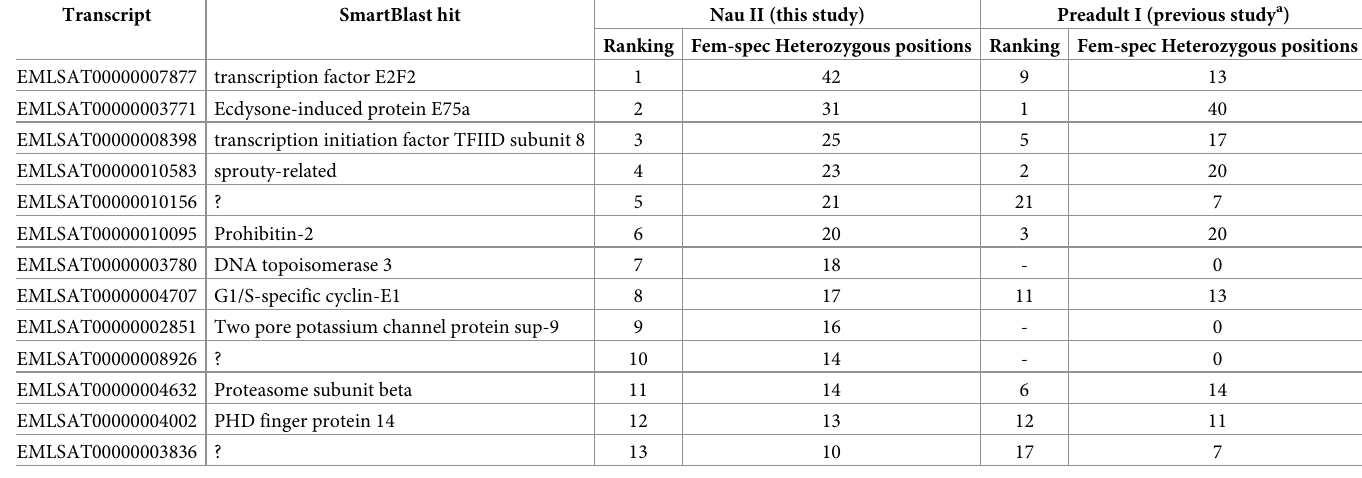
Table 1. Transcripts with more than 10 heterozygous positions in females after mapping.